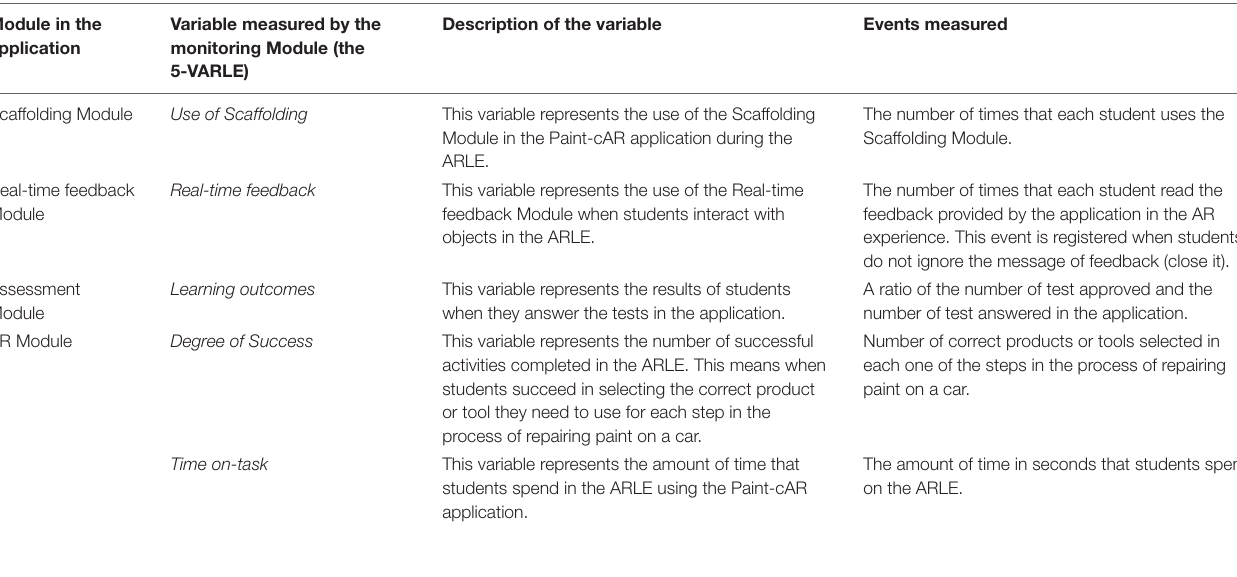
TABLE 3 | Modules of the Paint-cAR application and the 5-VARLE. Module in the Variable measured by the application monitoring Module (the